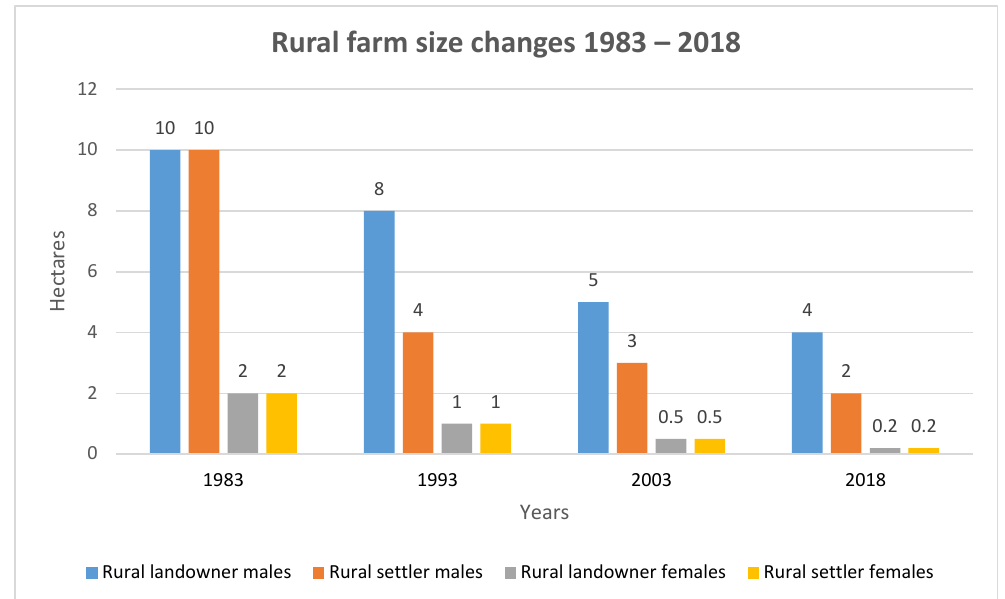
Figure 3. Changing farm sizes in the rural part of study area – Piina number 1 and 2, Fielmua and Figure3. Changingfarmsizesintheruralpartofstudyarea–Piinanumber1and2, Nimoro.